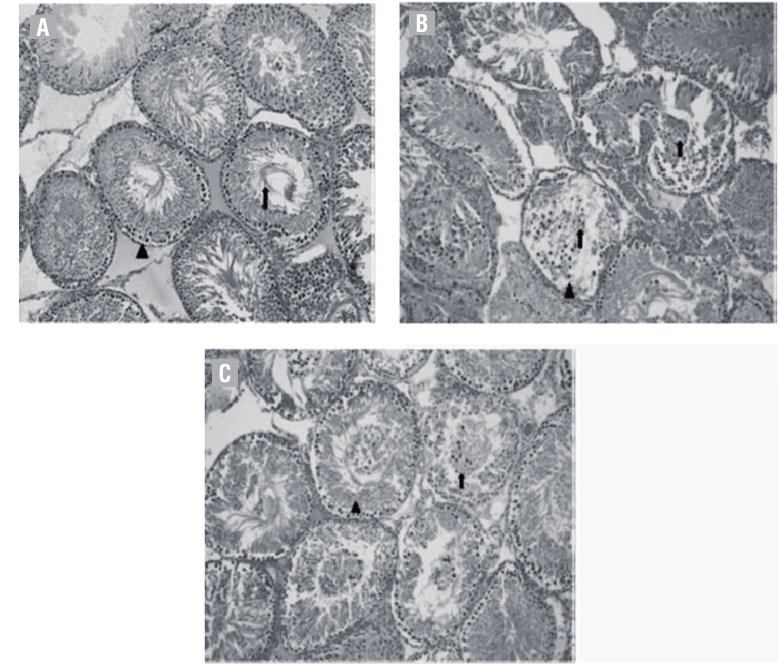
figure 1 - Ipsilateral testis (x200, hemotaxylin and eosin stain [h&E]). A) A section from the sham with group, normal seminiferous tubule epithelial structure ( ∆ ) and spermatozoons ( ↑ ) were observed. B) A section from the T/D group, seminiferous tubule germinal epithelial structure was completely poured ( ∆ ), and luminal irregular germinal cells ( ↑ ) were observed. c) A section from the medical ozone therapy group, the germinal epithelial structure was regular ( ∆ ) and regular lineage germinal epithelial cell ( ↑ ) observed in the